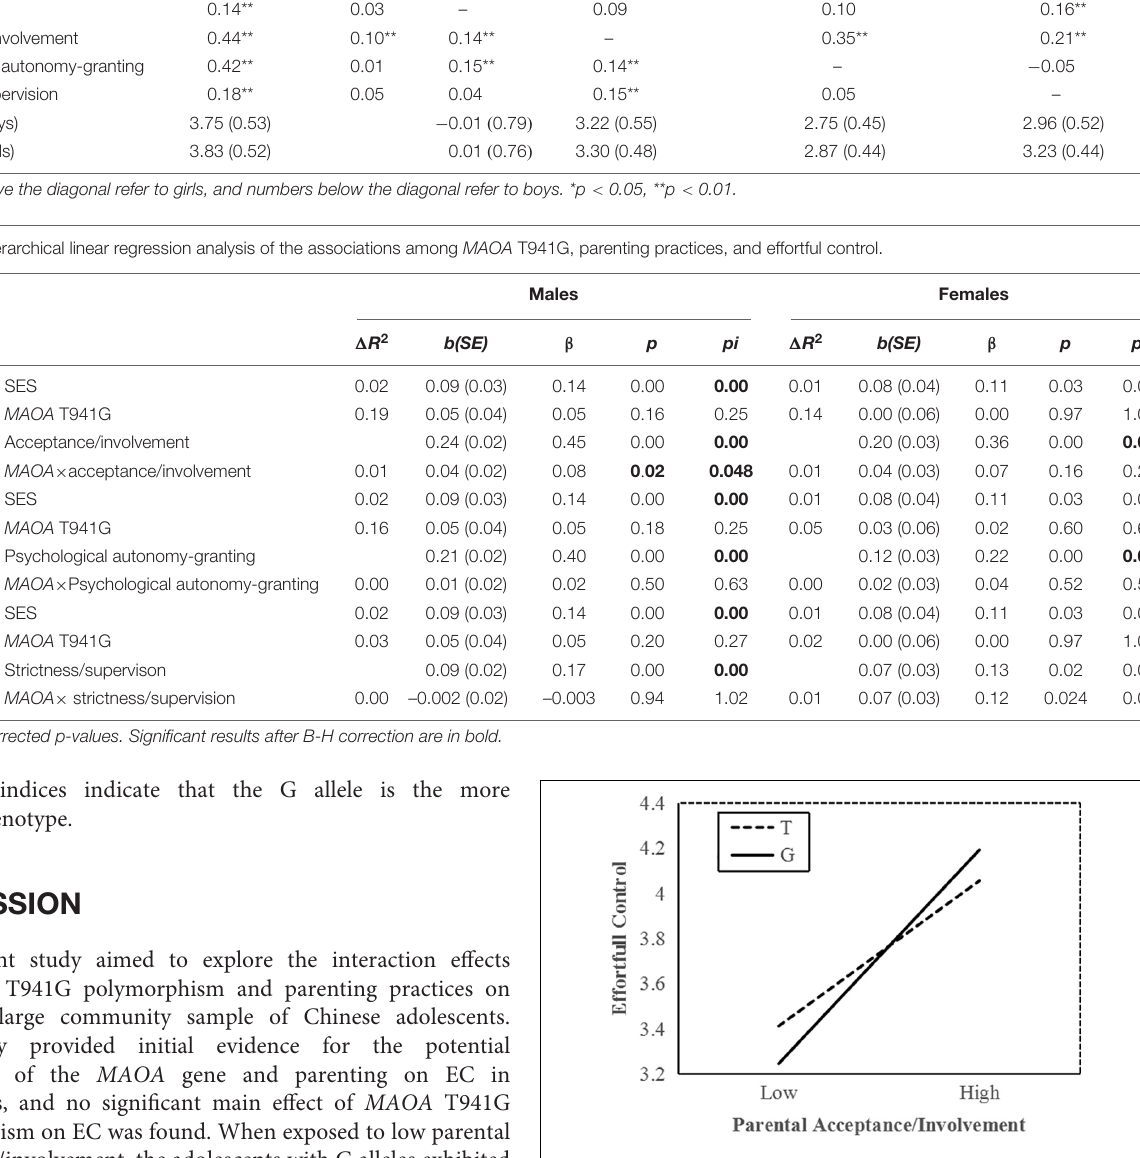
FIGURE 1 | MAOA T941G and parental acceptance/involvement in predicting EC in boys. Simple slopes predict EC from parenting practices in different genotype groups. Solid line, G allele; dashed line, T